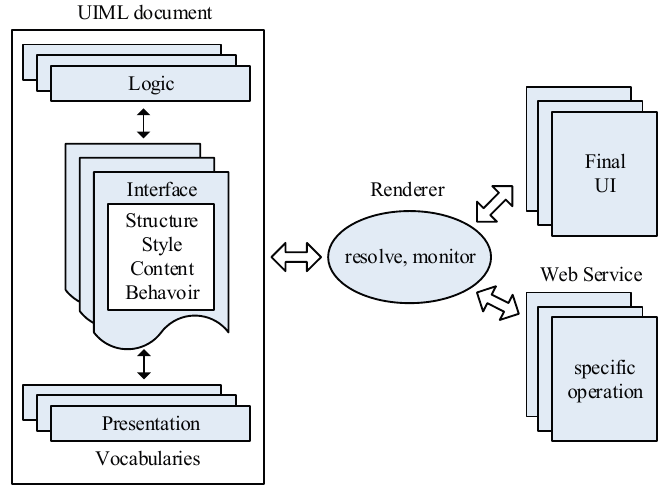
Figure 3. Dynamic Operation Description Document and its